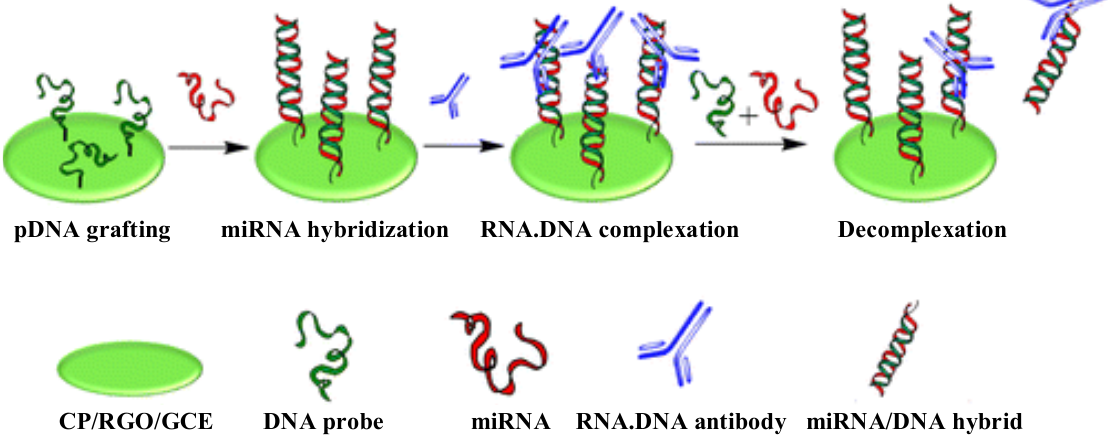
CP/RGO/GCE DNA probe miRNA RNA.DNA antibody miRNA/DNA